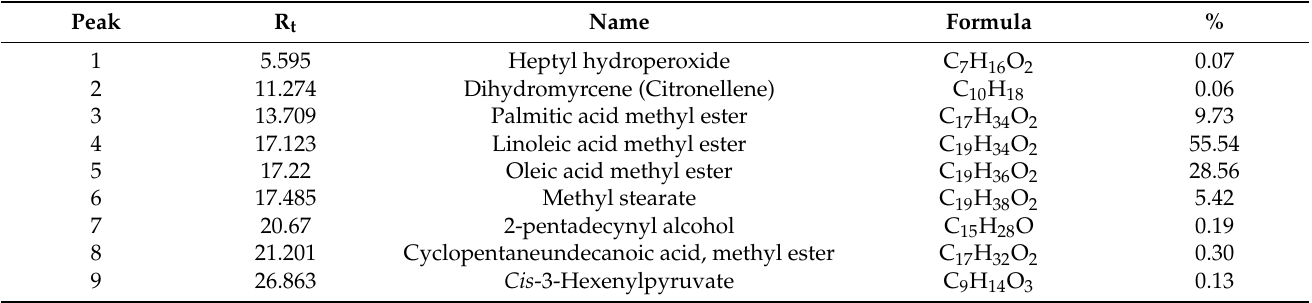
Table 1. Results of the GC/MS analysis of the lipoidal matter derived from Saussurea costus